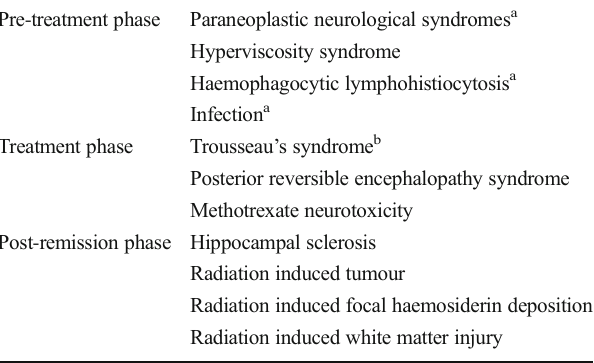
Table 1 Neurological complications associated with paediatric cancer Pre-treatment phase Paraneoplastic neurological syndromes